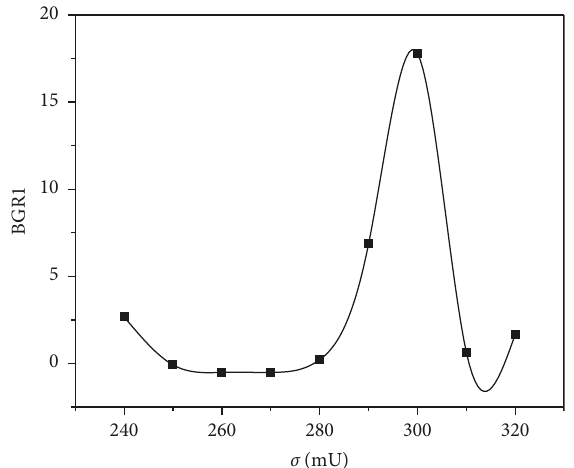
Figure 4: Group A under low-intensity aerobic